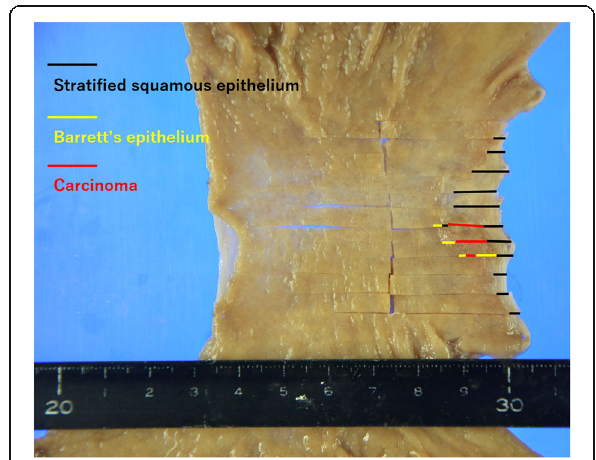
Fig. 2 Macroscopic findings. The surgical specimen shows an elevated mass (type 0-IIa; 10 × 8 mm) at the esophagogastric junction. Stratified squamous epithelium, Barrett ’ s epithelium, and the carcinoma are indicated